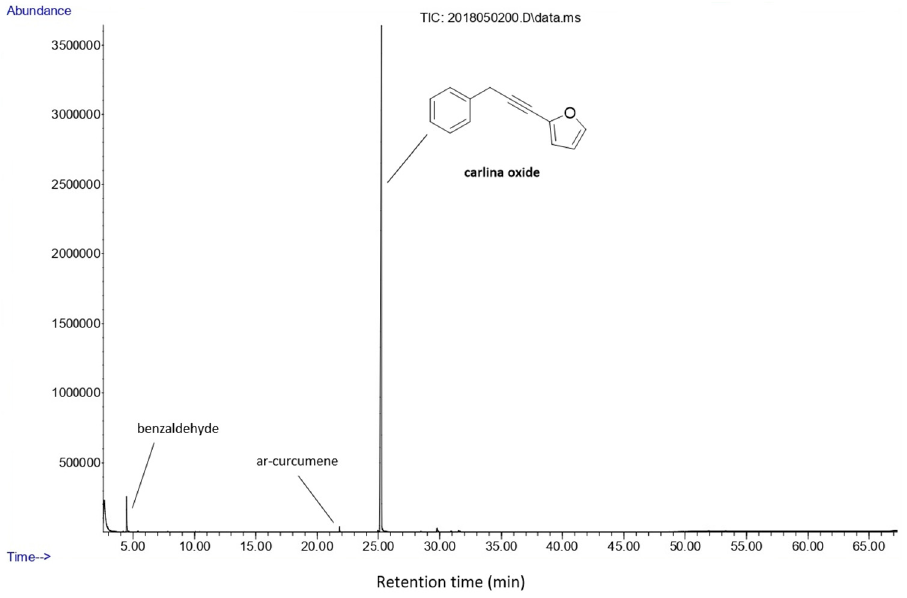
Figure 1. Gas chromatography–mass spectrometry (GC–MS) chromatogram of the essential oil obtained from the roots of Carlina acaulis . The separation of peaks was achieved using a HP-5MS (5% phenylmethylpolysiloxane, 30 m length × 0.25 mm internal diameter, 0.1 µm film thickness). For the achievement of C. acaulis EO-based NE, the sample was subjected to a pressure of 130